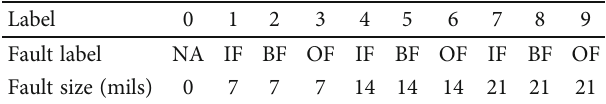
Table 2: The details of CWRU.